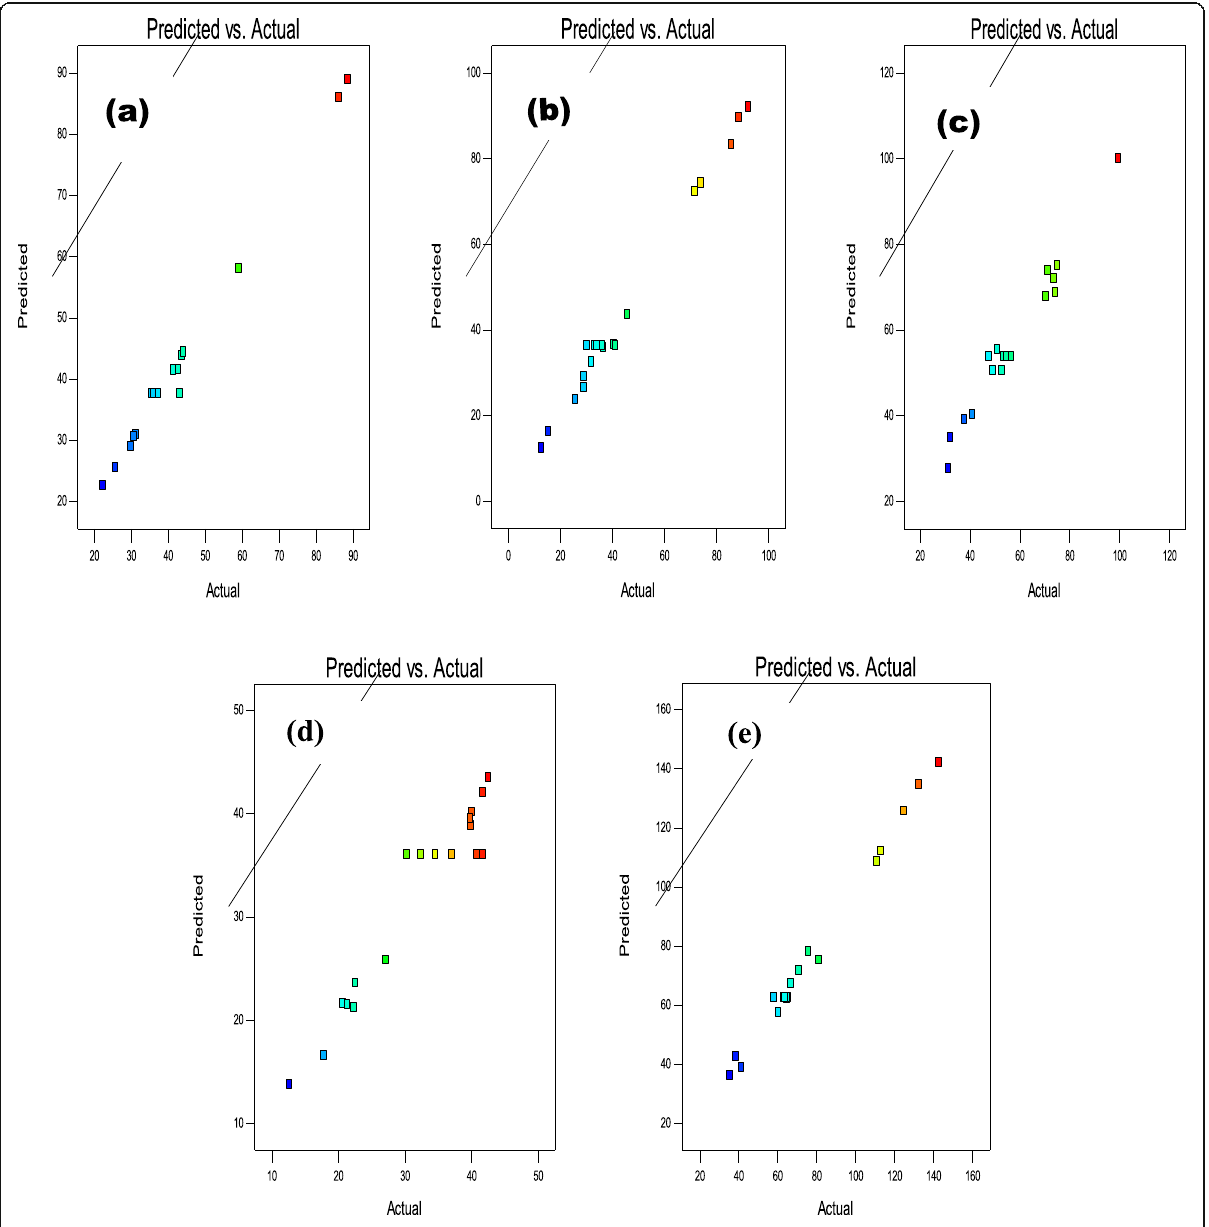
Fig. 2 Diagnostics plots of actual vs. predicted values for a serum MDA levels, b CAT activity, c SOD activity, d GST activity, and e POD